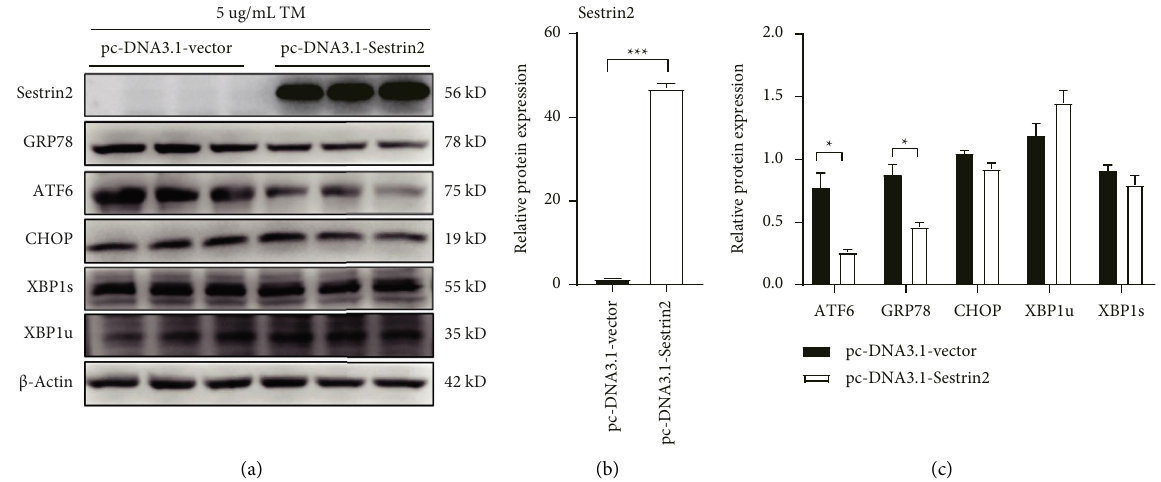
Figure 2: Sestrin2 overexpression ameliorates TM-induced ER stress. (a) Representative western-blot results of Sestrin2 and ER stress- related proteins, ATF6, GRP78, CHOP, XBP1u and XBP1s in the indicated groups. (b) Western blot quantitative analysis of Sestrin2 (unpaired two-tailed t -test; t (4) �− 38.44, P < 0 . 001). (c) Western blot quantitative analysis of ER stress-related proteins (unpaired two- tailed t -test; for ATF6: t (4) � 4.32, P � 0.012; for GRP78: t (4) � 4.54, P � 0 . 010). ∗ P < 0 . 05, ∗∗∗ P < 0 .